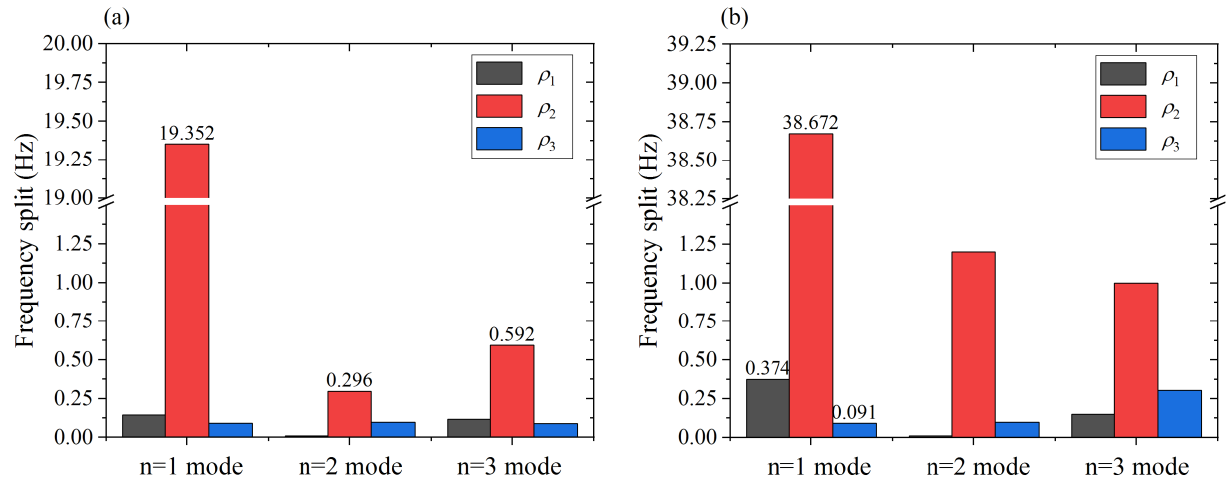
Figure 7. Frequency split of the n = 1, 2, and 3 modes: ( a ) When the harmonic error ρ i = 32 kg/m 3 ; ( b ) When the harmonic error ρ i = 65 kg/m 3 .